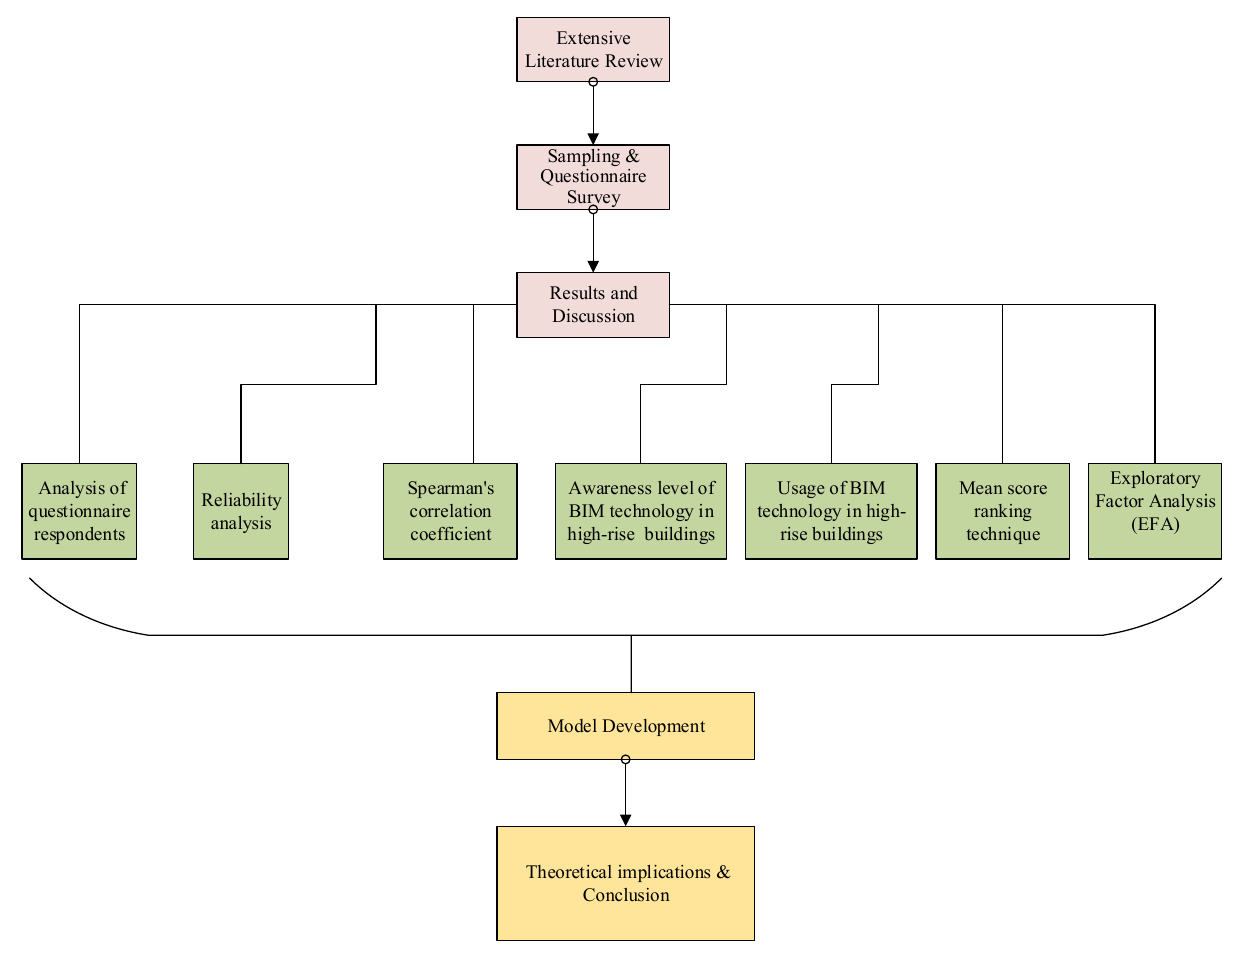
Figure 1. Research flowchart design.